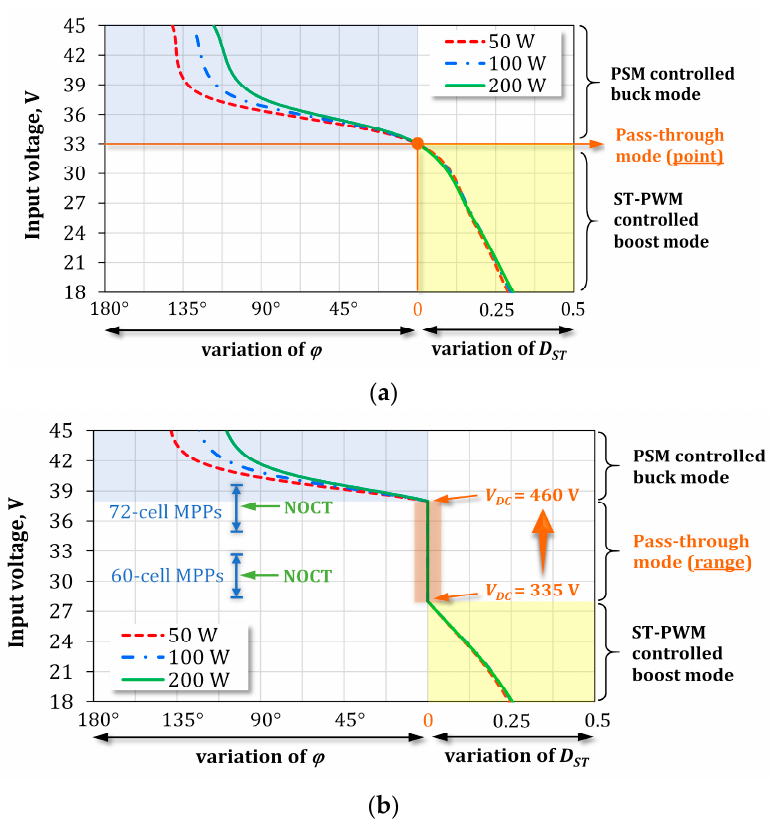
Figure 4. Control variables of the front-end converter in the microinverter topology shown in Figure 3 [18] at fixed ( a ) and variable ( b ) dc-link voltage control.